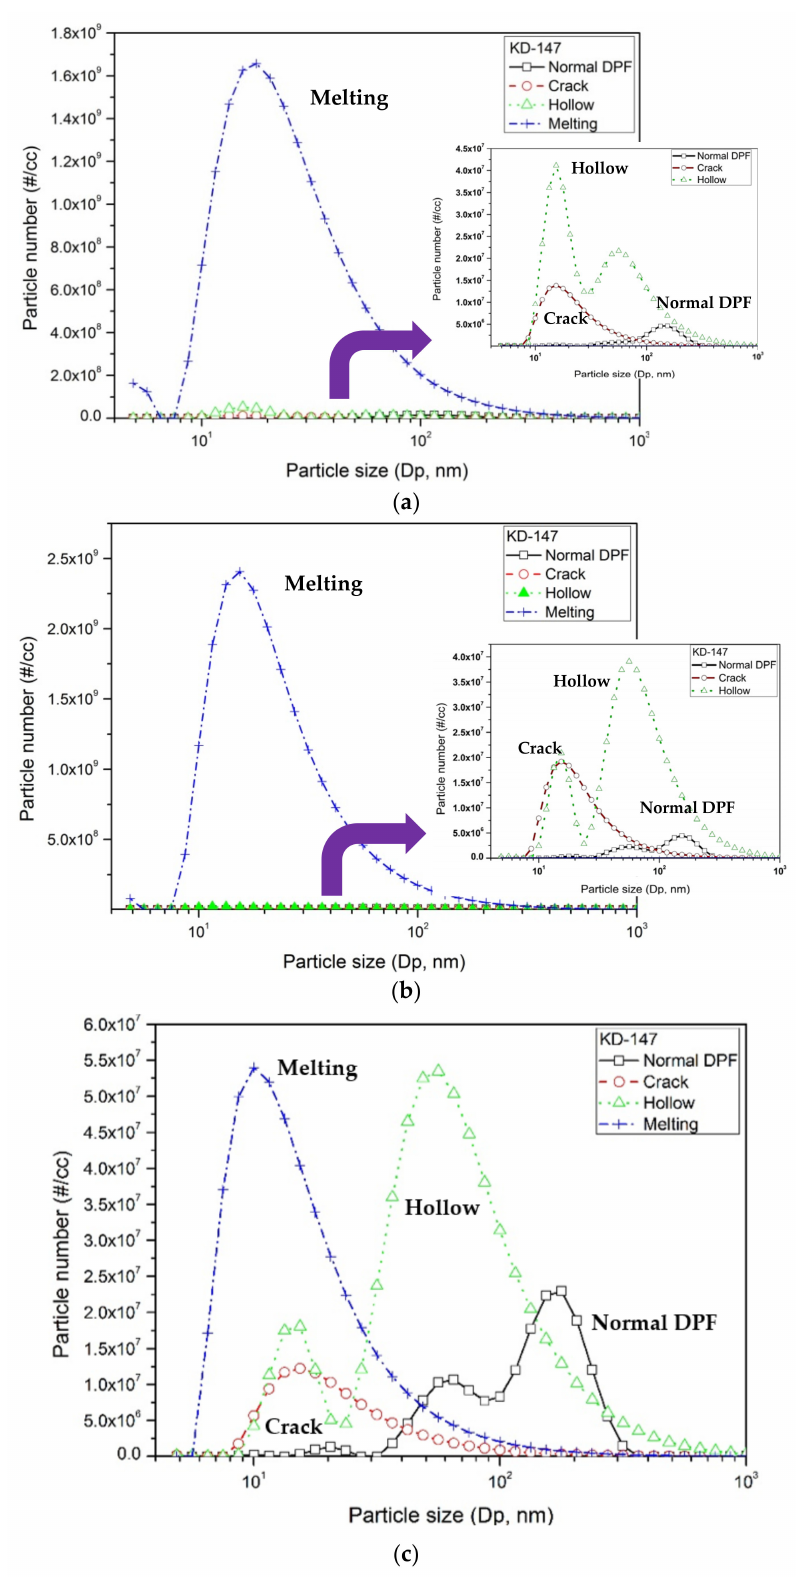
Figure 14. Particle number density by particle size at three positions during KD-147 driving mode. ( a ) Point 1 (at 32 s) during KD-147 mode. ( b ) Point 2 (at 77 s) during KD-147 mode. ( c ) Point 3 (at 108 s) during KD-147